Question: What style of plot is this figure drawn as?
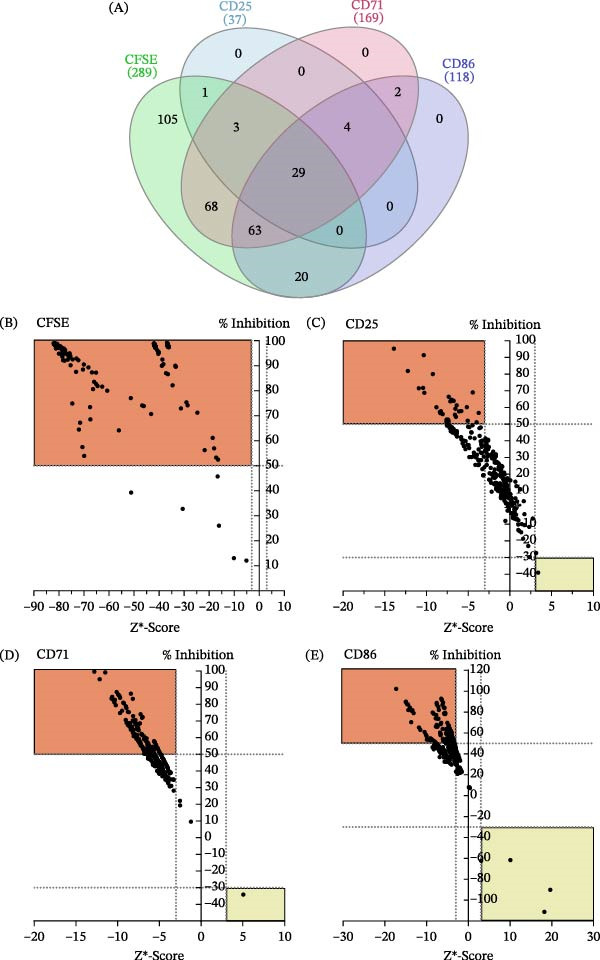
Answer: scatter